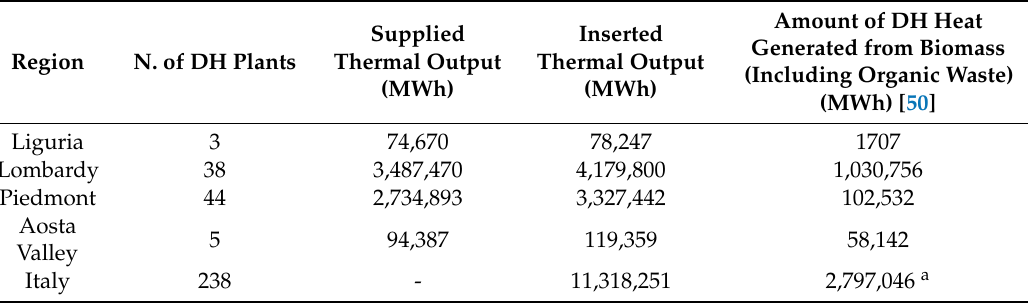
Table 3. Number and thermal output of DH